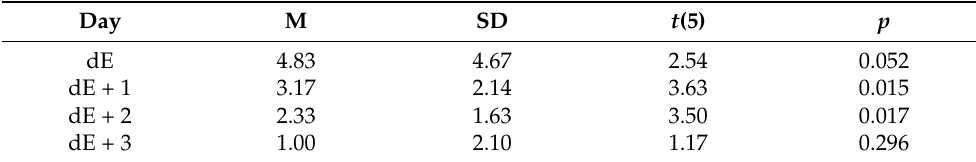
Table 7. Means and standard deviations of behavioral reactions to grain ( n =